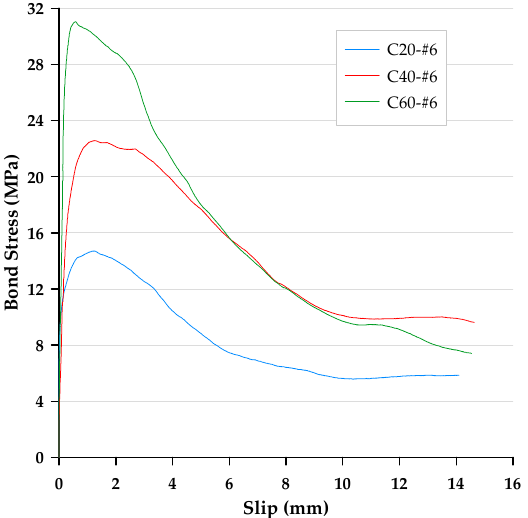
Figure 7. Local bond stress–slip curve for specimens with the #6 rebar.